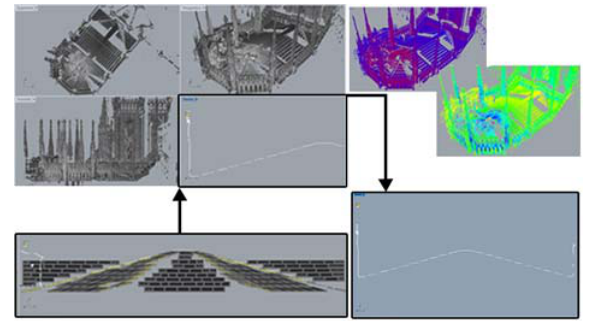
Figure 6. Importing and viewing the cloud. Top line: Importing a big size cloud with the possibility of different styles of visualization (on the right). Bottom line: cropped cloud, creation of profiles and sections.